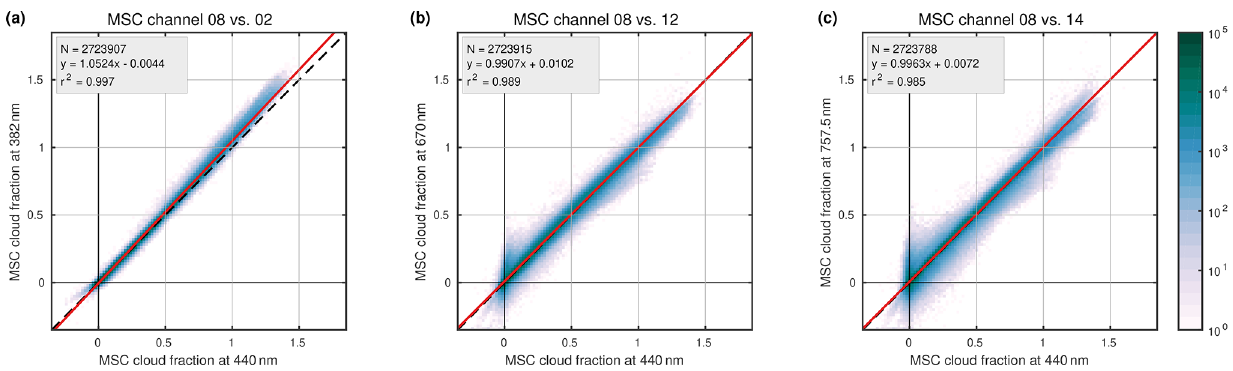
Figure 15. Comparison between MICRU MSC channel 8 at 440nm and MSC channels (a) 2 at 382nm, (b) 12 at 670nm, and (c) 14 at 757.5nm for April 2010. The plots correspond to the combinations indicated by circles in Fig.